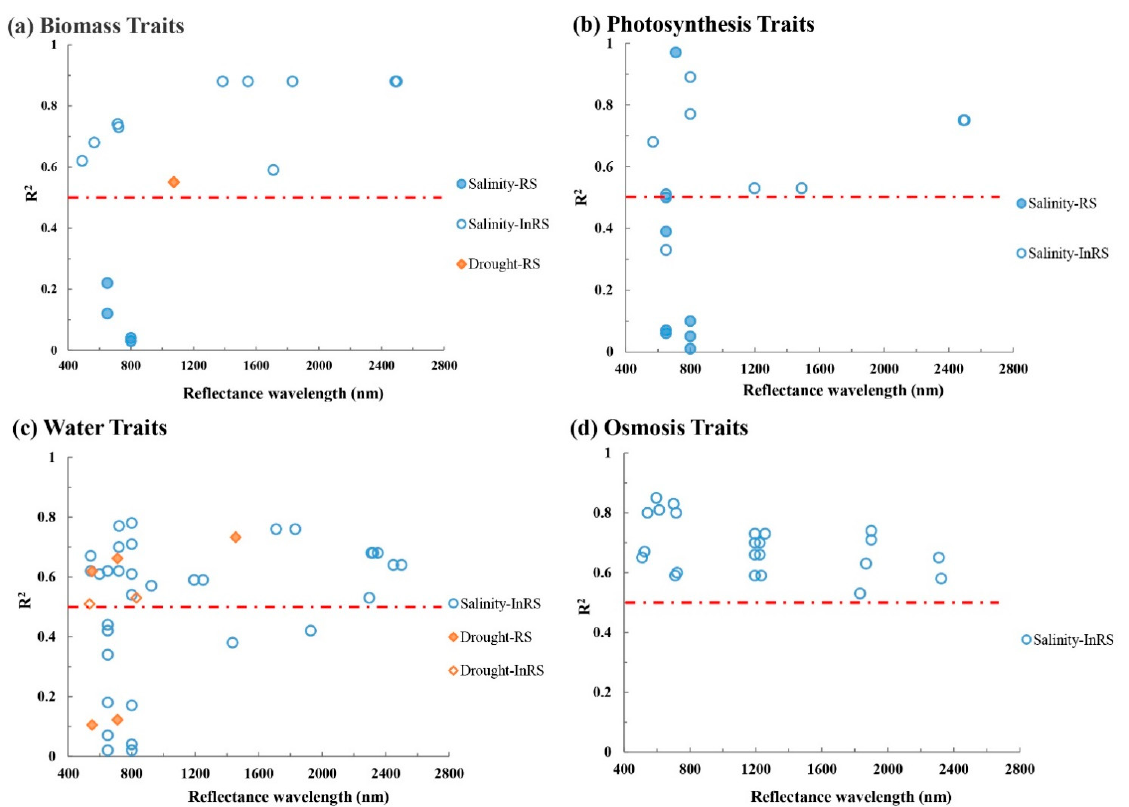
Figure 5. Relationship between R 2 and wavelength of different traits clusters under drought/salinity stress. RS identifies traits that can be directly measured by RS; InRS identifies traits that can be indirectly measured by RS. The red line indicates R 2 > 0.50.